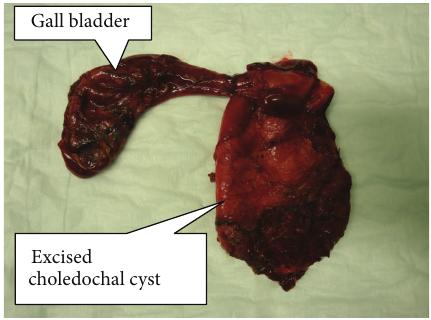
Figure4:Resectedspecimenofcompletelyexcisedcholedochalcyst with gall bladder (patient